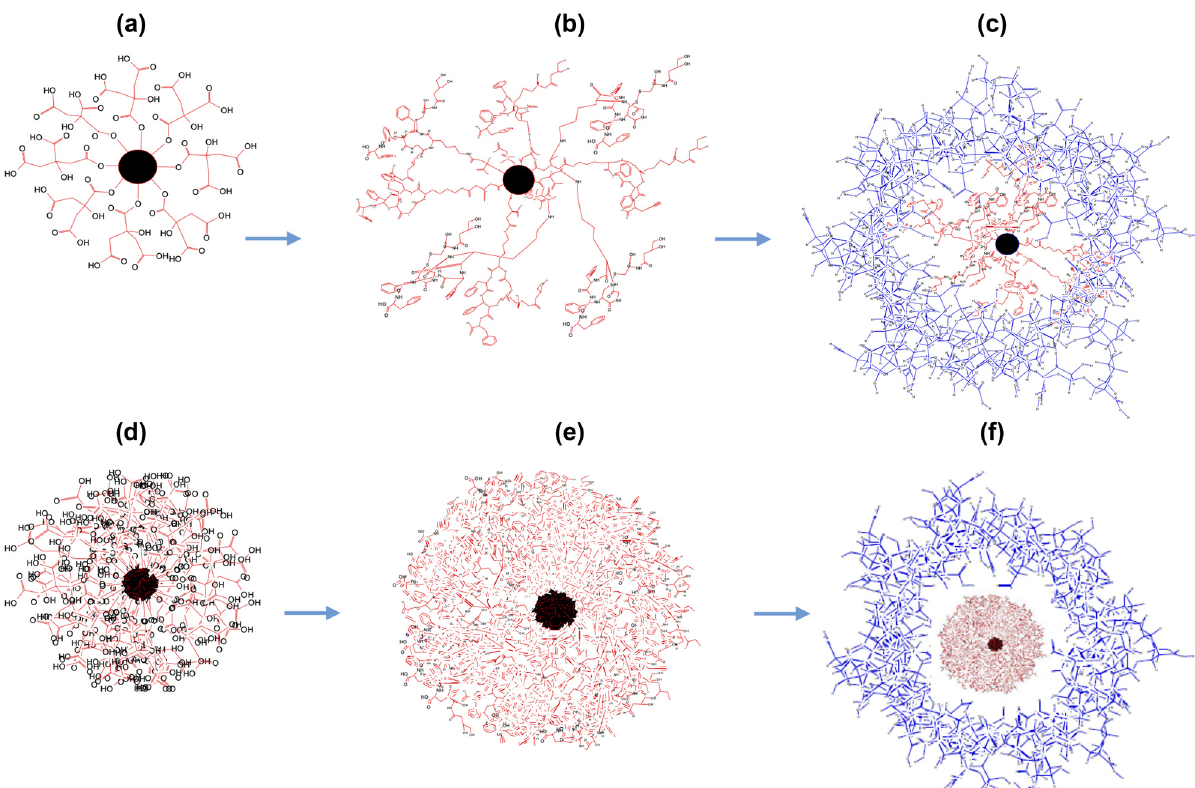
Figure 9: Structural representations of the AgNP nanocarriers; ( a – c ) 2D renderings, ( a ) AgNPs – CTT ( citrate bound to the nanoparticle, nanoparticle depicted in black ) . ( b ) AgNPs – OCT ( OCT covalently bound to citrate, CTT ) . ( c ) AgNPs – OCT – Alg ( no chemical bonding; instead, physical wrapping of the alginate around the AgNPs – OCT. Alg: alginate, coatings shown in blue ) . 3D renderings of the AgNPs. ( d – f ) 3D renderings, ( d ) AgNPs – CTT. ( e ) AgNPs – CTT – OCT. ( f ) AgNPs – OCT – Alg. Alginate coatings are not chemically bound. The core of the formu - lated AgNPs – OCT is shown in red, while the surrounding alginate wrapping is shown in